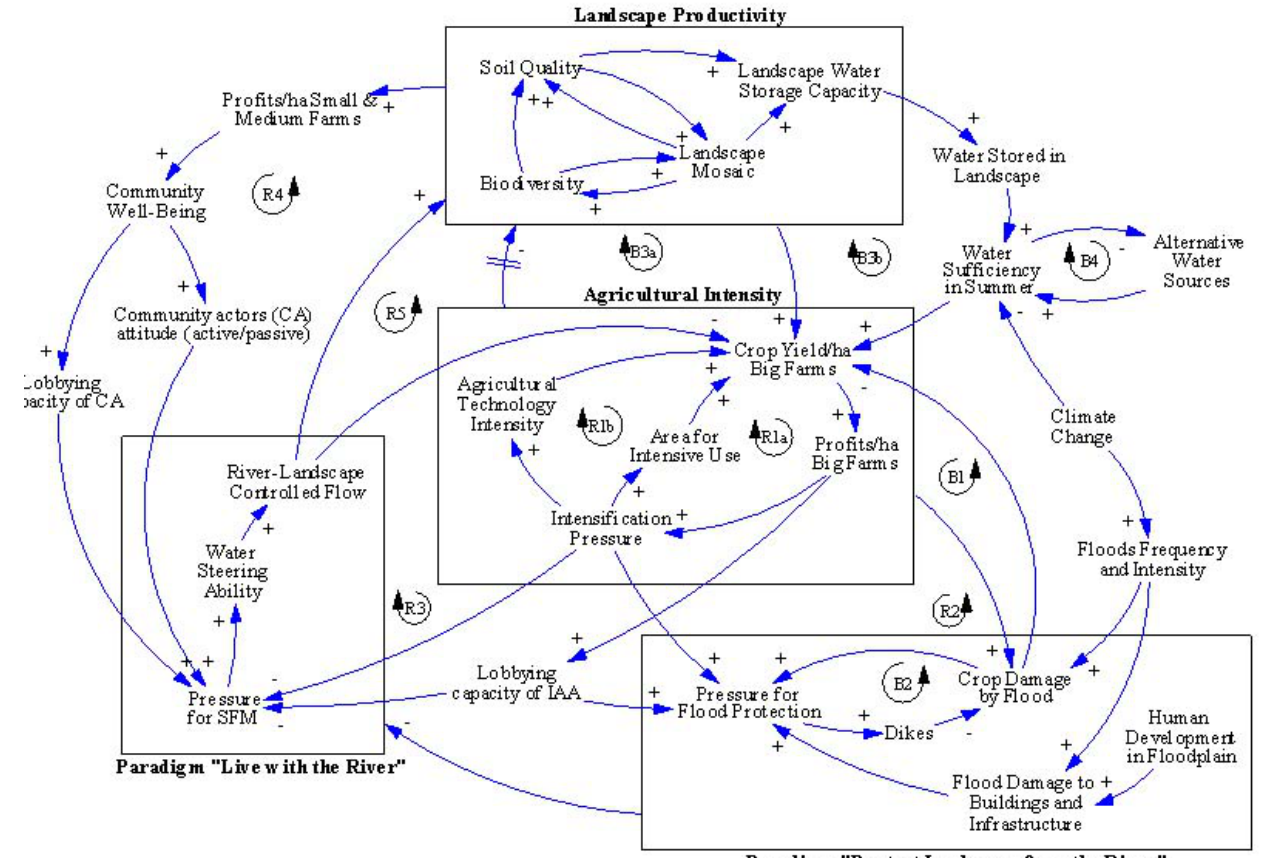
Fig. 4. Processes represented by causal loops supporting either the conventional or the alternative paradigms to river management in the Tisza River